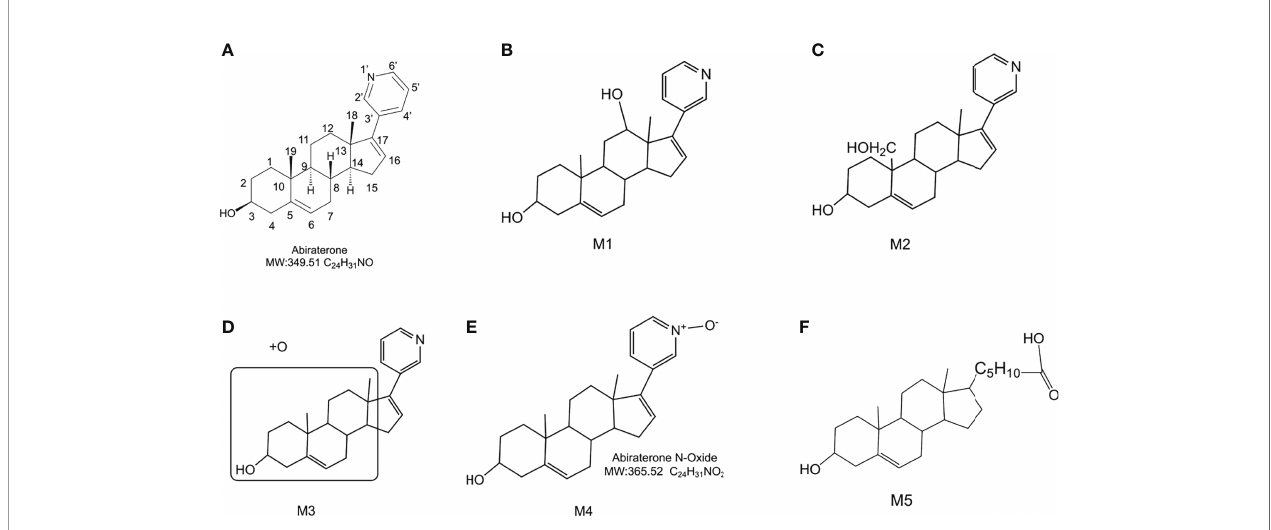
FIGURE 4 | The chemical structure of Abiraterone and possible chemical structures of Abiraterone metabolites. (A) The chemical structure of Abiraterone (Abiraterone is numbered according to the IUPAC carbon numbering scheme). (B) The possible chemical structure of Abiraterone metabolite M1. (C) The possible